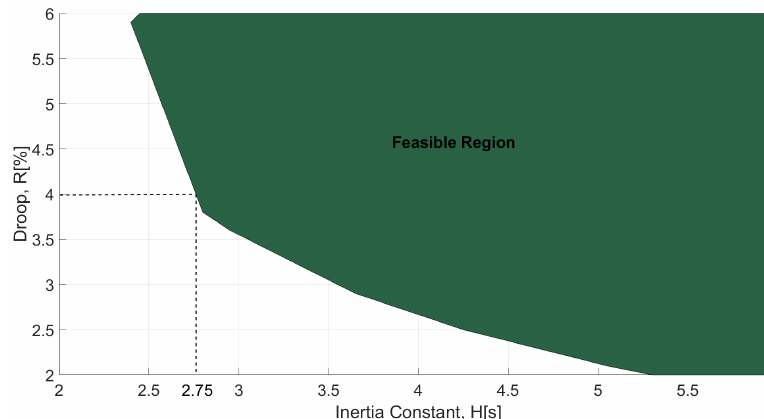
Figure 12. Feasibility of different R for different H for Fossil Steam